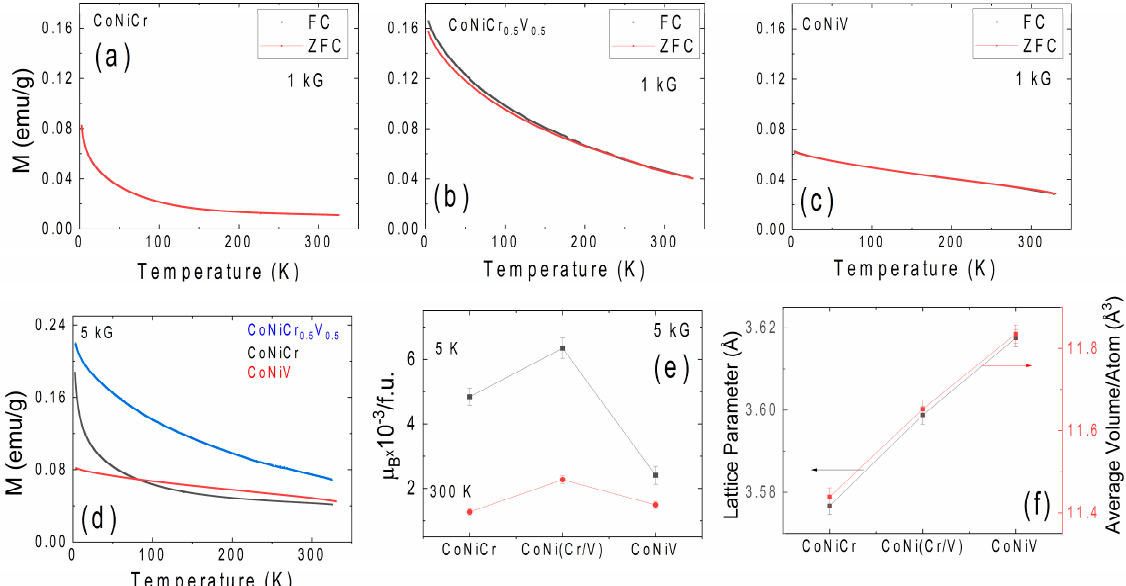
Figure 4. ( a – c ) The temperature dependence of the ZFC and FC magnetization of the CNC, CNCV, and CNV measured in a 1kG magnetizing field. ( d ) The temperature dependence of the ZFC magnetization of all the samples measured in 5 kG. ( e ) The compositional dependence of the magnetic moment at 5 K and 300 K. ( f ) The compositional dependence of the Lattice parameter and average atomic volume for all samples.